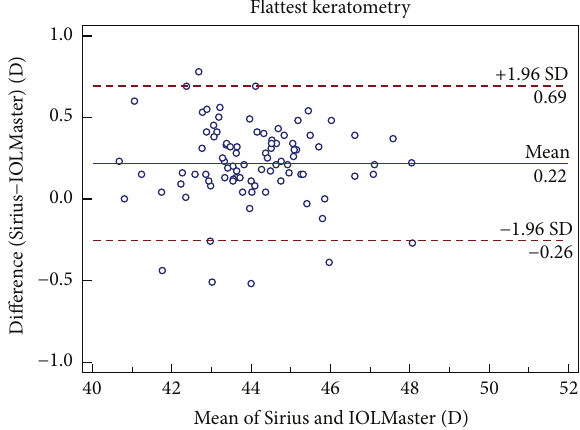
Figure 2: Bland-Altman plots of agreement of keratometry values along the flattest meridian taken with the Sirius Scheimpflug/ Placido photography-based topography system and IOLMaster partial coherence interferometry. The solid line indicates the mean difference (bias). The upper and lower lines represent the 95% limits of agreement.